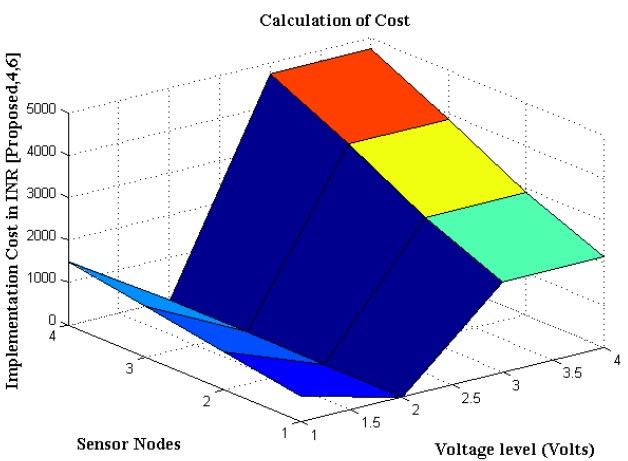
Figure 7. Calculation of cost for connected sensors.